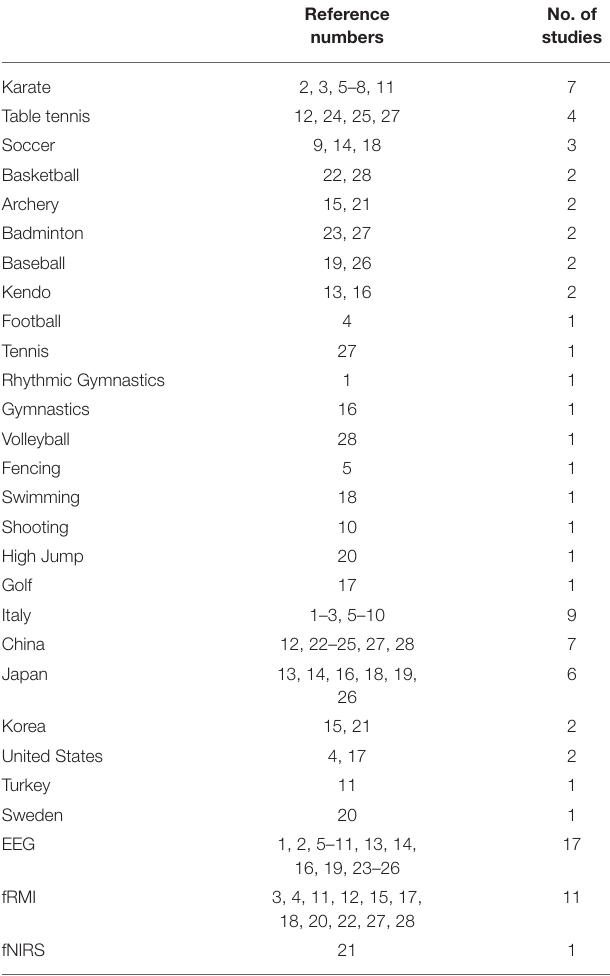
TABLE 2 | Frequencies of expert sports, countries, and neurophysiological techniques in selected studies ( N =